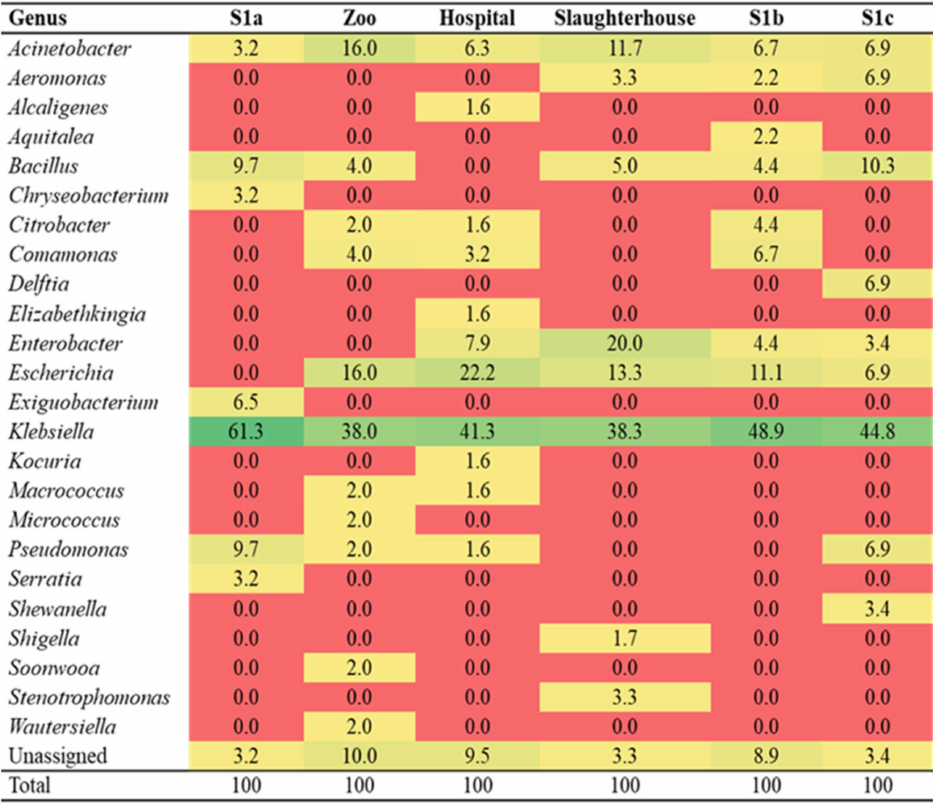
Figure 5. Culturable sulfonamides-resistant bacteria population by identification of 16S Sanger sequencing. The culturable that could not be identified were grouped as